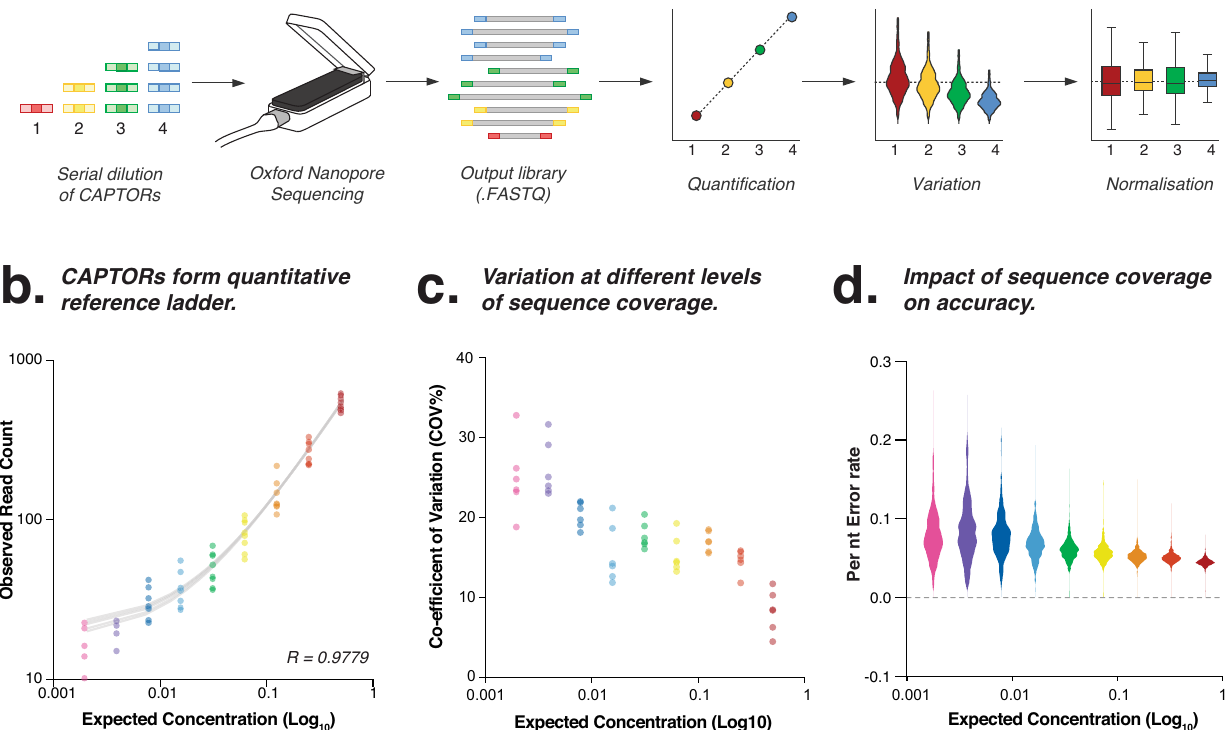
Fig.3|QuantitativeanalysisusingCAPTORs.a Schematicdiagramillustratesthe preparation ofa master mixturethat constitutes a staggered dilution of CAPTORs. Use of the staggered CAPTORs master mix generates an internal quantitative reference ladder that can be used to measure technical variation and improve normalisation between samples. b Scatter plot compares the observed CAPTOR count relative to their expected concentrations, forming a staggered reference ladder to evaluate the quantitative performance of an individual library.